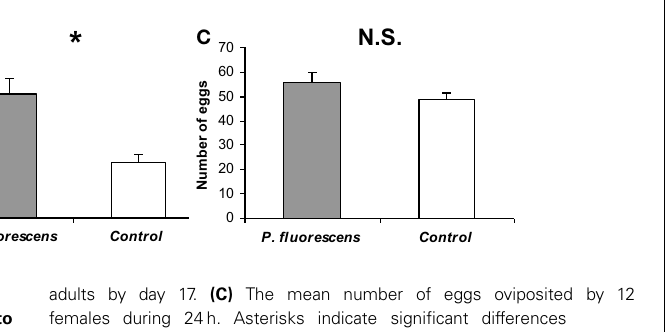
FIGURE 1 | Reproductive performance of B. tabaci on P. fluorescens WCS417r pre-inoculated and non-inoculated tomato plants. (A) The proportion of live nymphs from the total number of eggs oviposited. (B) The proportion of progeny that had emerged as